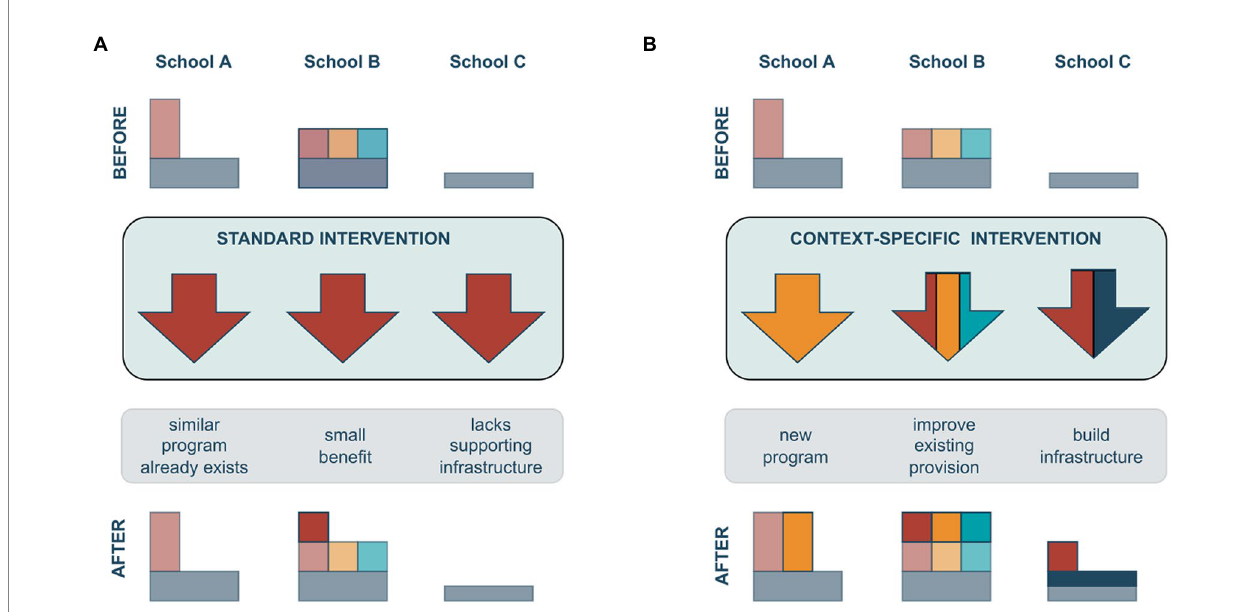
FIGURE 1 Standard intervention (A) compared to context-specific intervention (B) . In a standard intervention, each school receives the same intervention, regardless of school-specific context. In a context-specific intervention, the intervention is tailored to be most effective for each specific